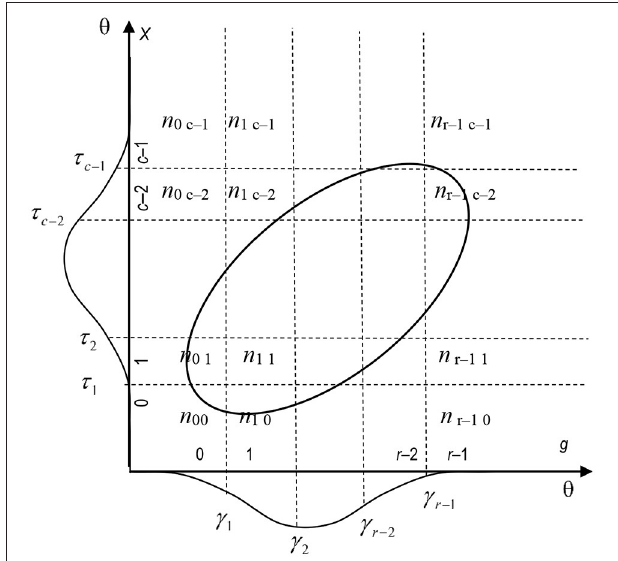
FIGURE 2 | One latent variable θ manifested in two different